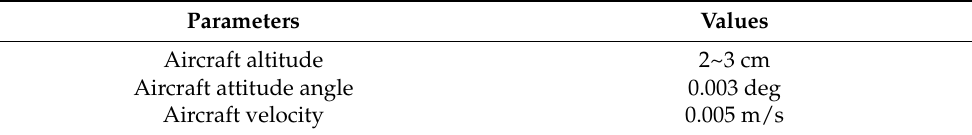
Table 2. Pos_av610 absolute accuracy specifications.